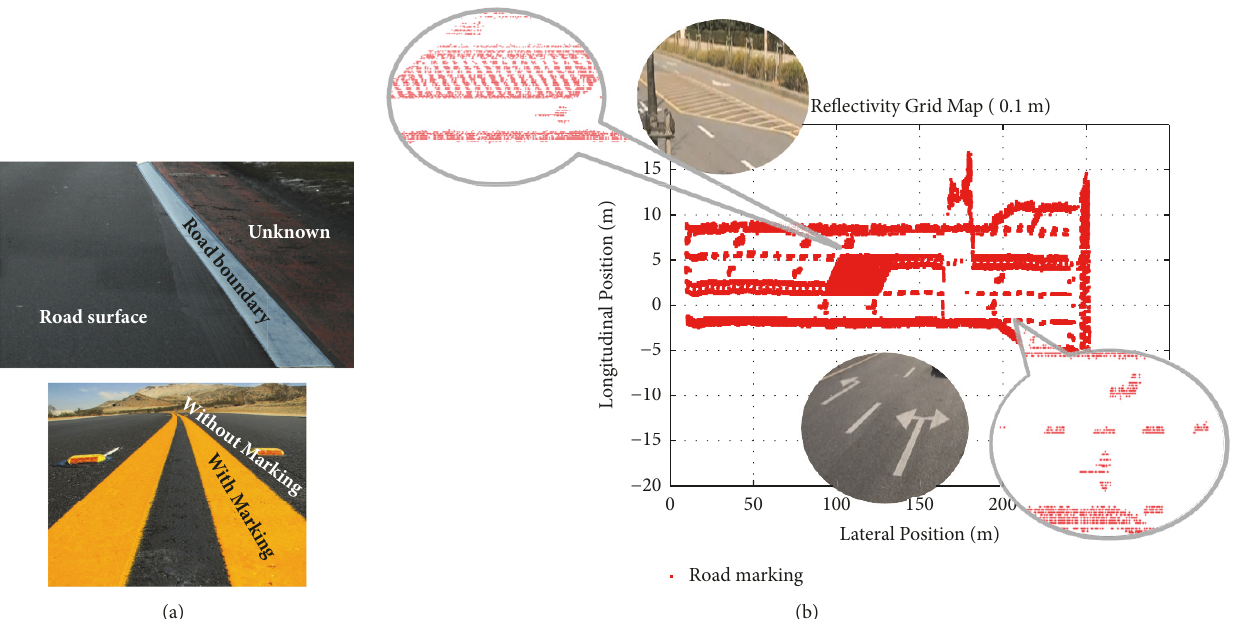
Figure 6: Four states of the road region and various lane markings used on the map: (a) the four states of the road region and (b) various lane markings shown on the information map.